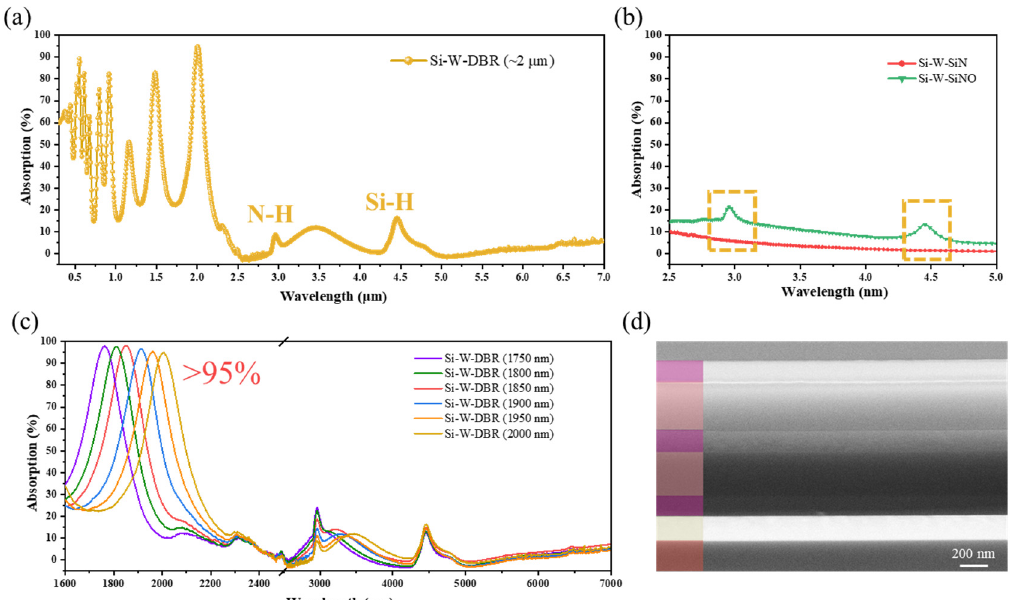
Figure 3. ( a ) Experimental optical absorption spectrum of Si-W-SiN/SiNO multilayer structure with TPP resonance peak at 2 µ m; ( b ) experimental optical absorption spectra of Si-W-SiN and W-SiNO single-layer structure; ( c ) experimental optical absorption spectra of fabricated Si-W-SiN/SiNO multilayer structure with different TPP resonance peaks at 1750, 1800, 1850, 1900, 1950, and 2000 nm, respectively; ( d ) SEM characterization of fabricated Si-W-SiN/SiNO multilayer struc- ture.